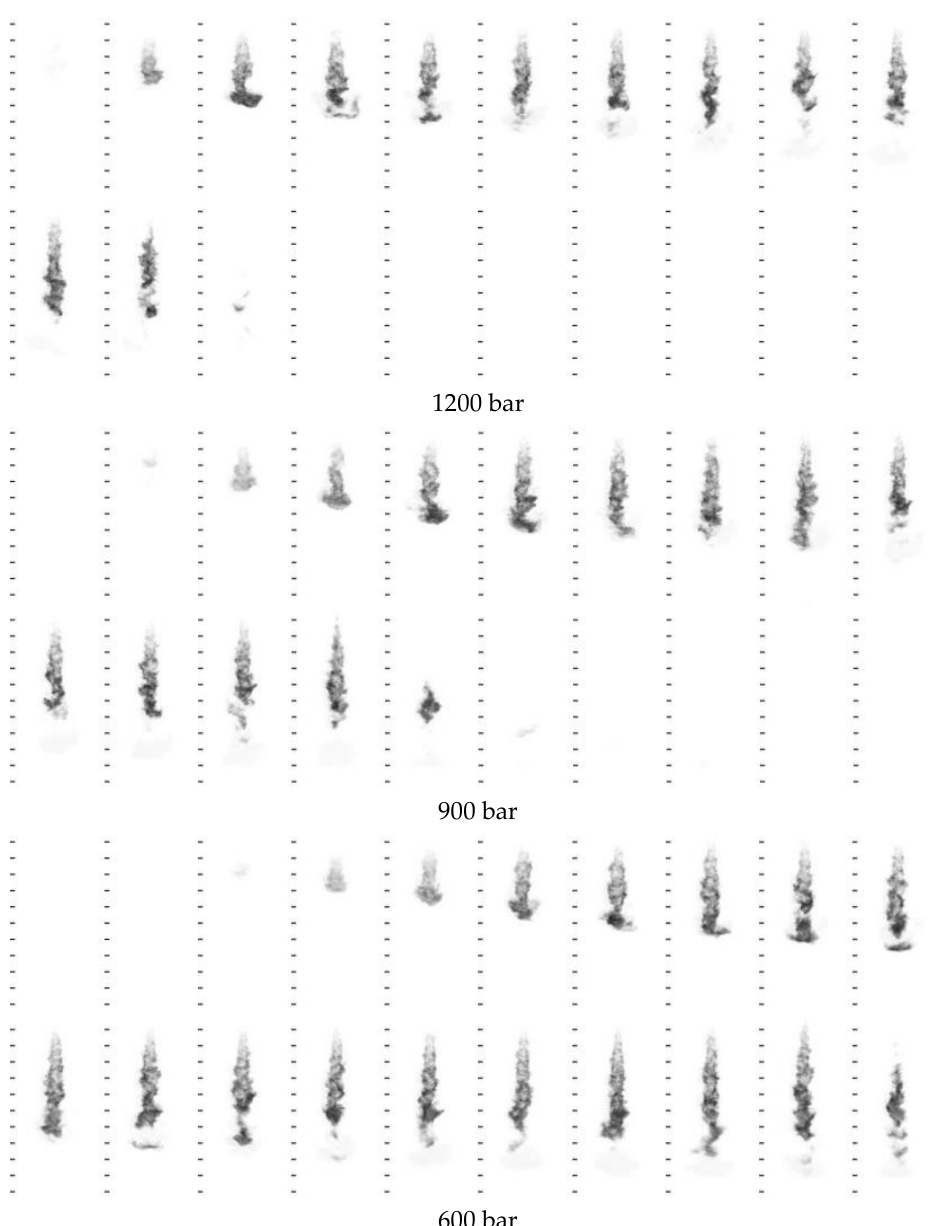
Figure 7. Effects of injection pressure on diesel combustion flame in a 50% O 2 nitrogen-free environ- ment.